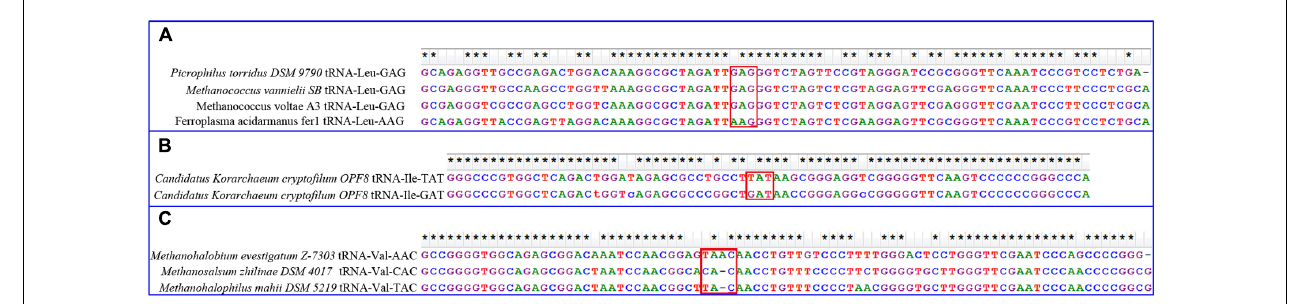
FIGURE 5 | Alignment of gained tRNAs and the best BLAST hits. (A) Alignment of leucine tRNA-AAG in Ferroplasma acidarmanus fer1 genome and three other BLAST hits. They are all without intron. (B) Alignment of isoleucine tRNA-UAU in Candidatus Korarchaeum cryptofilum OPF8 genome and a BLAST hits. The former has an intron, which is removed before alignment. (C) Alignment of valine tRNA-AAC and two BLAST hits. They all have introns, which are removed before alignment. Stars at the top indicate sequences identical at corresponding sites. Red boxes are predicted sites for anticodons. The alignments are produced by ClustalW with default